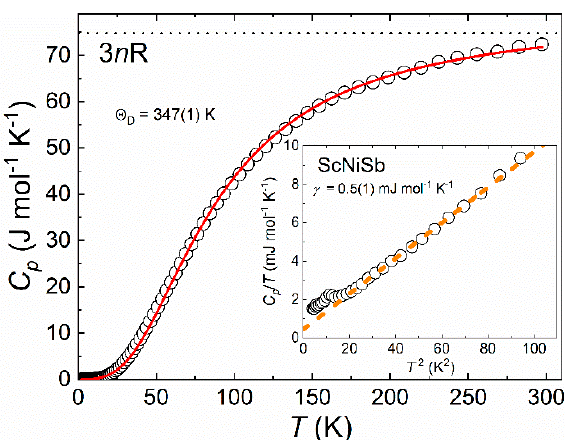
Figure 5. Temperature dependence of the specific heat of ScNiSb. Solid line represents Debye model. Dotted line represents the Dulong–Petit limit (3 n R). Inset: the low-temperature C p / T vs. T 2 data, dashed line is a linear fit.